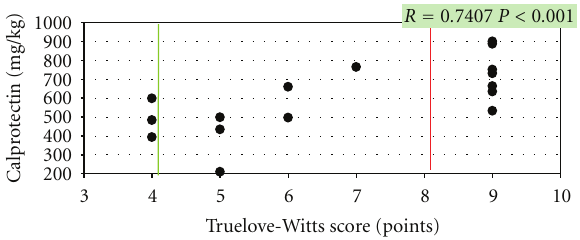
Figure 3: Correlation between calprotectin concentrations and the Truelove-Witts score in UC children.